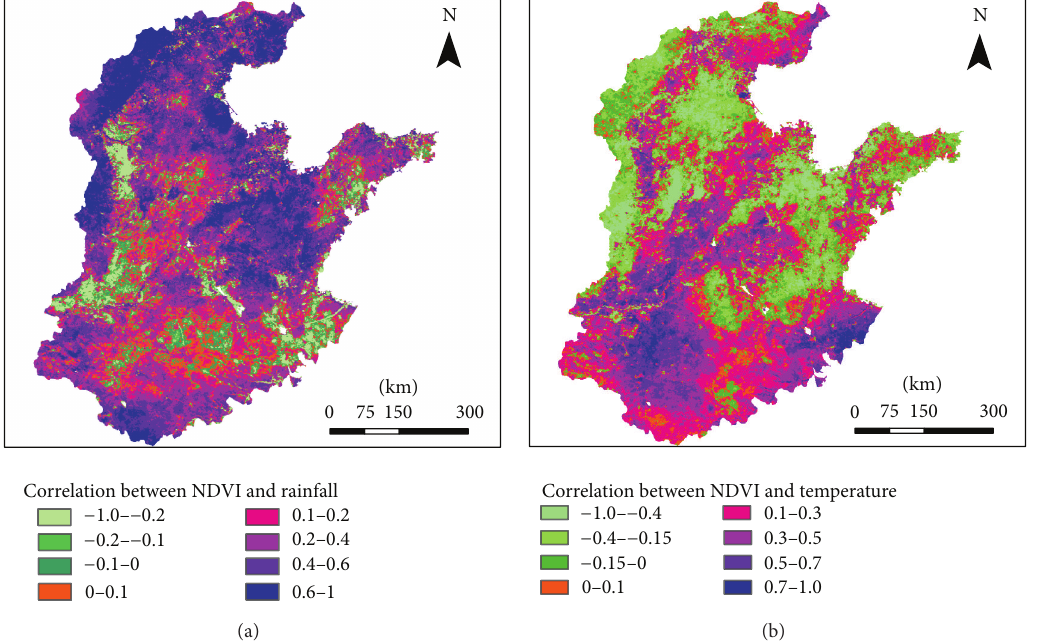
Figure9:Spatialpatternsofcorrelation(a)betweenannualaverageNDVIandrainfalland(b)betweenannualaverageNDVIandtemperature at the pixel level in the North China